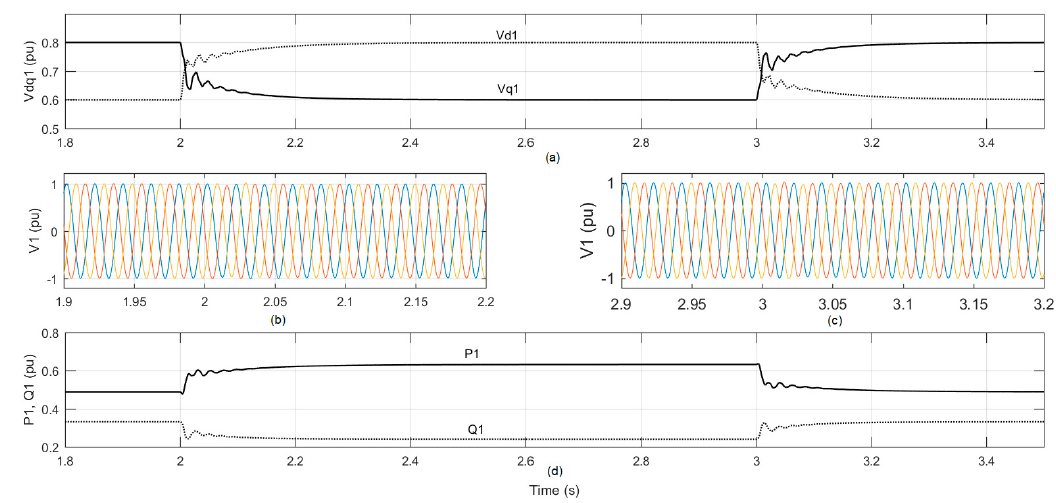
Figure 4. Proposed controllers’ performance of DG 1 as a result of two-step changes in the voltages set point. ( a ) dq-components of the load voltage at point of coupling (PC) 1. ( b , c ) Instantaneous load voltages of PC 1. ( d ) Output active and reactive power of DG 1.